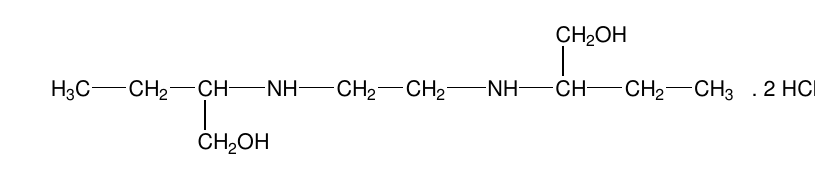
Figure 1 . Structure of Ethambutol